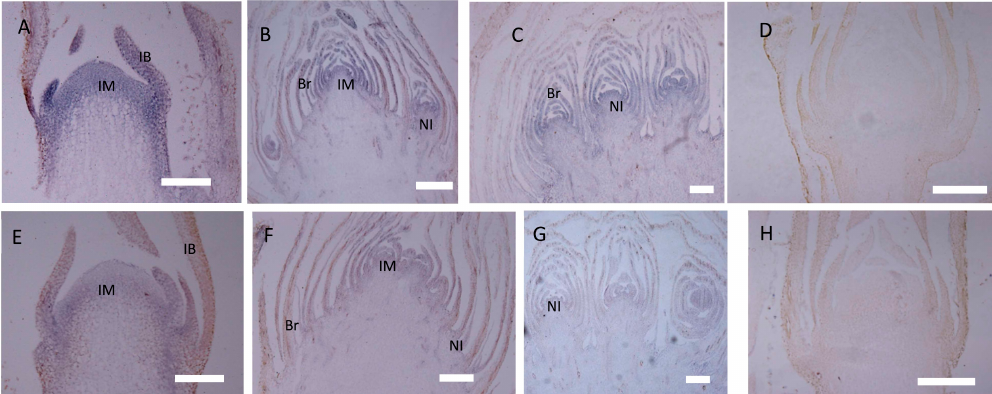
Figure 8. In situ hybridization of CbLFY and CbUFO in gh cosmos. ( A ) Expression of CbLFY was detected in the young dome-shaped IM, but did not reach the surface, and was absent in young IB;